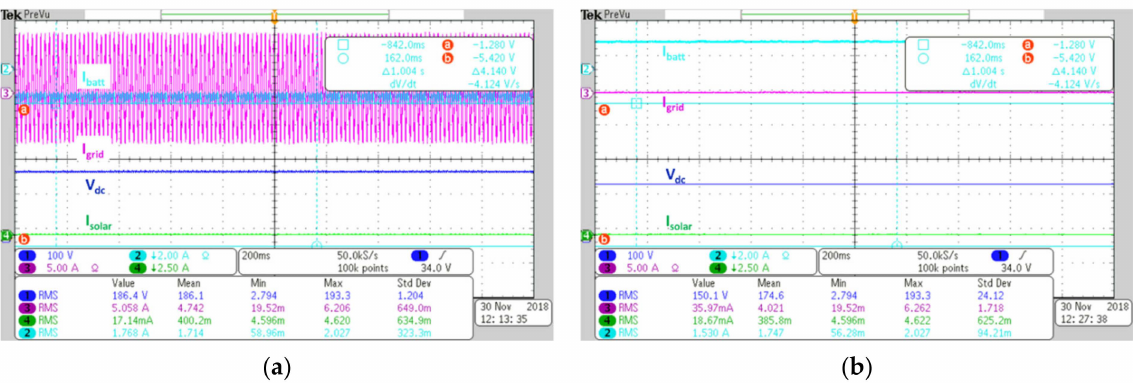
Figure 11. Response of MPEI with trained Q-learning-based EMS for different States. ( a ) State 1; ( b ) State